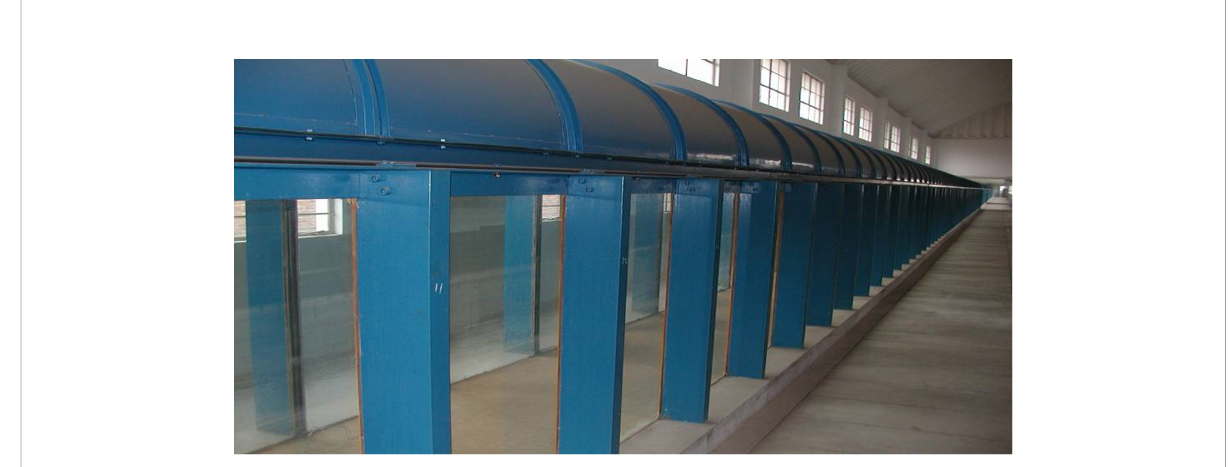
FIGURE 1 Photo of the wave fl